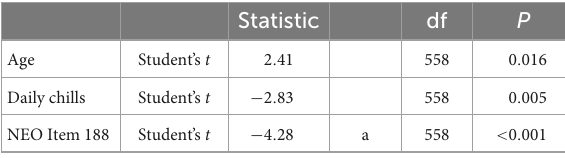
TABLE 1 A gold standard for aesthetic chills: the top 10 validated videos from our study, including the top three for each category (film, music, and speech). Video title Type Video description Average chills Jurassic